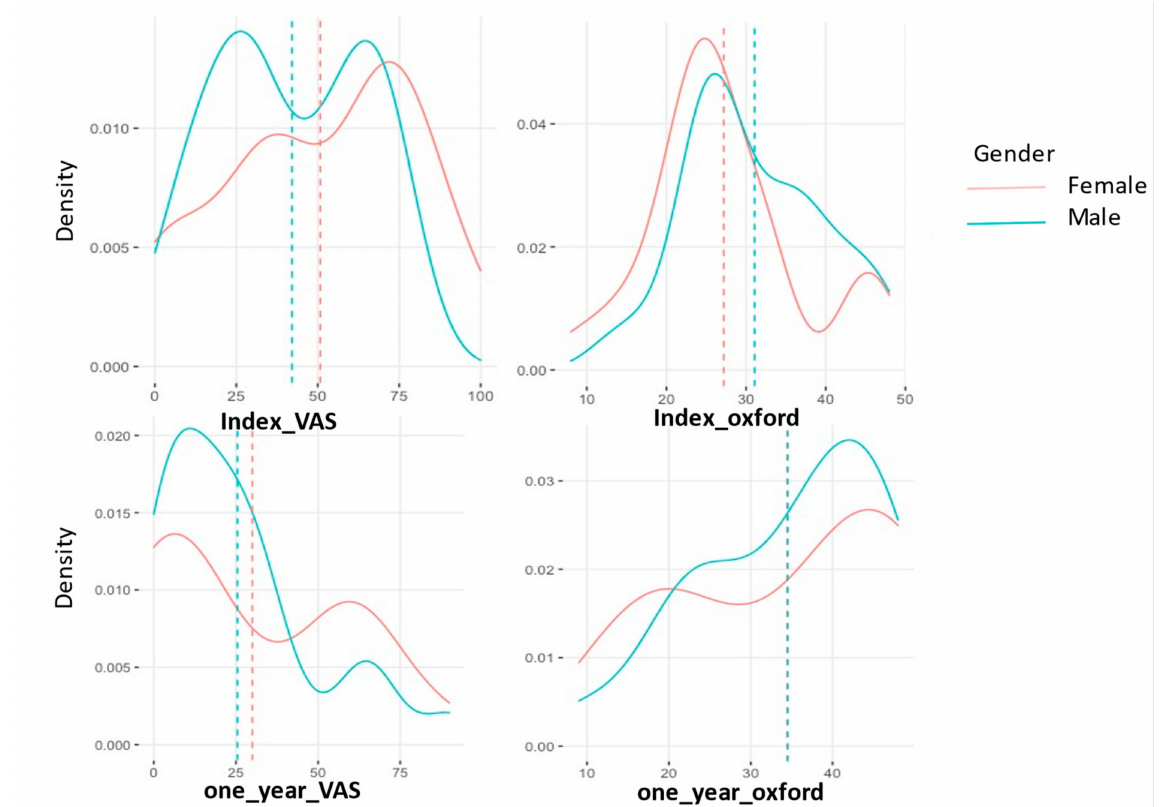
Figure 5. Index (pre-operative) and 1 year (post-operative) VAS and OHS density distribution in patients who received MFAT + PRP. The x -axis shows VAS (0–100) and OHS (0–48) pre and 1 years post MFAT injection. The y -axis shows the density distribution of the